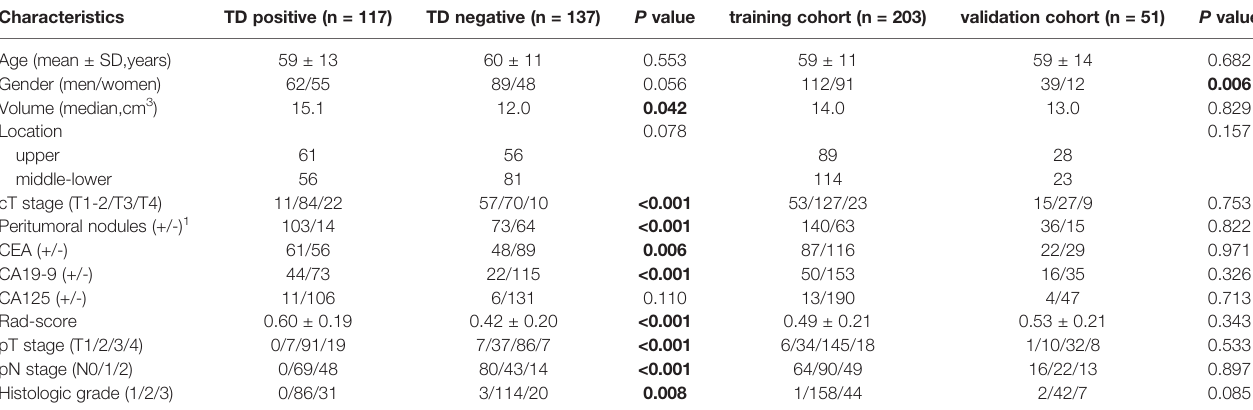
TABLE 1 | Baseline characteristics of the study population.